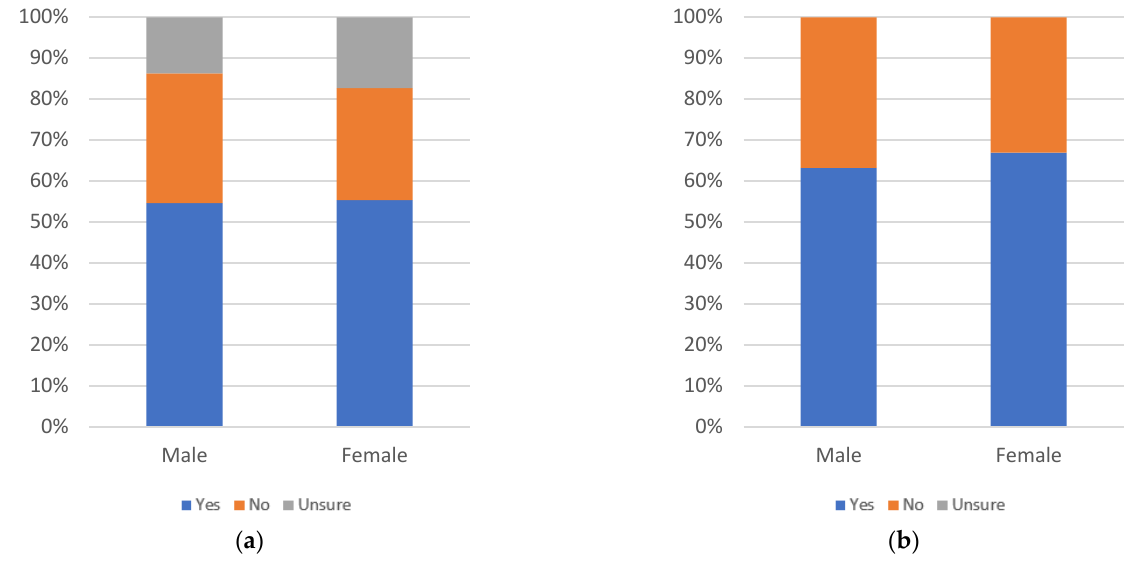
Figure 45. Label use, by gender: ( a ) with uncertain respondents (left) and ( b ) without uncertain respondents (right).